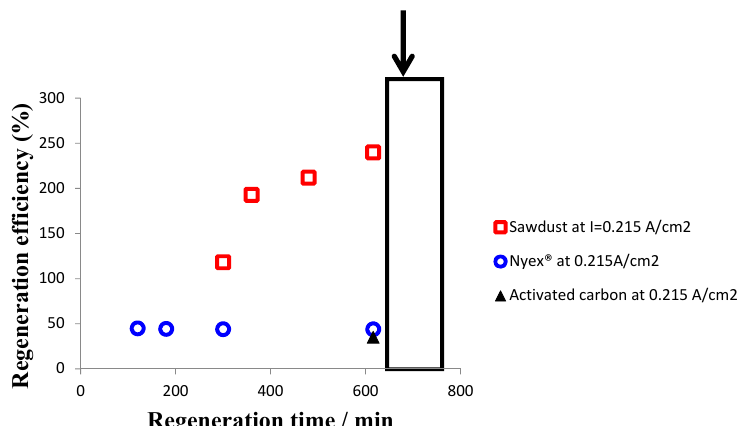
Fig. 5: Comparison of regeneration efficiency of different adsorbent with electrolysis time and applied current intensity. Operating conditions: m ads = 1g for AC and sawdust, 16 g for Nyex®, V= 200 mL, [Na 2 SO 4 ] =0.1 M, T=303 K.